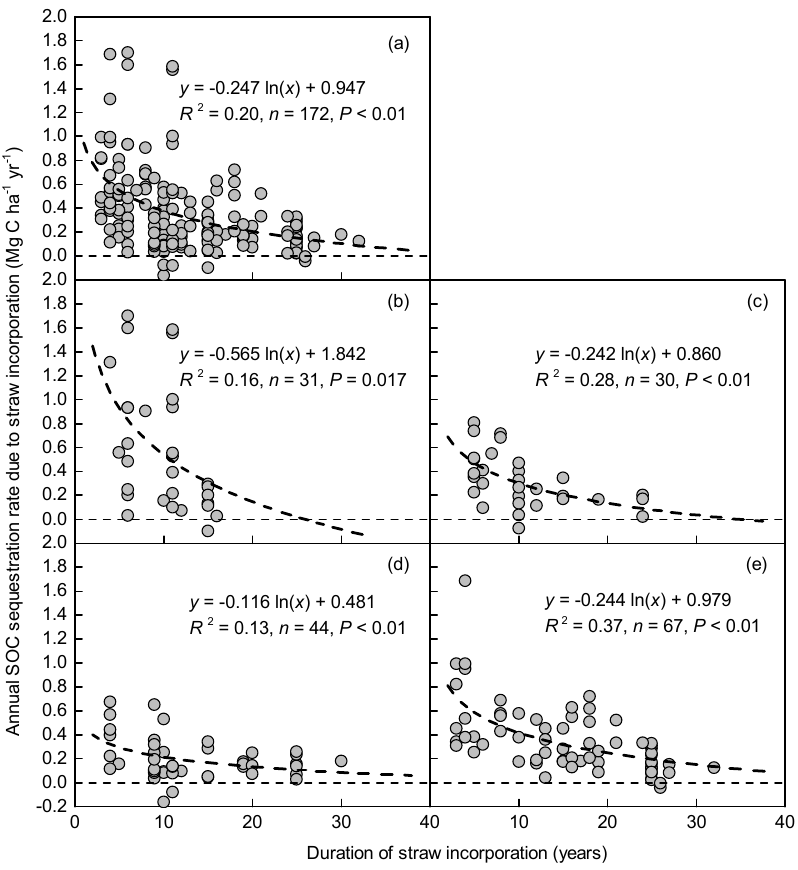
Figure 7. Relationships between annual soil organic carbon (SOC) sequestration rate and SI duration for (a) national scale, (b) northeast China, (c) north China, (d) northwest China and (e) south